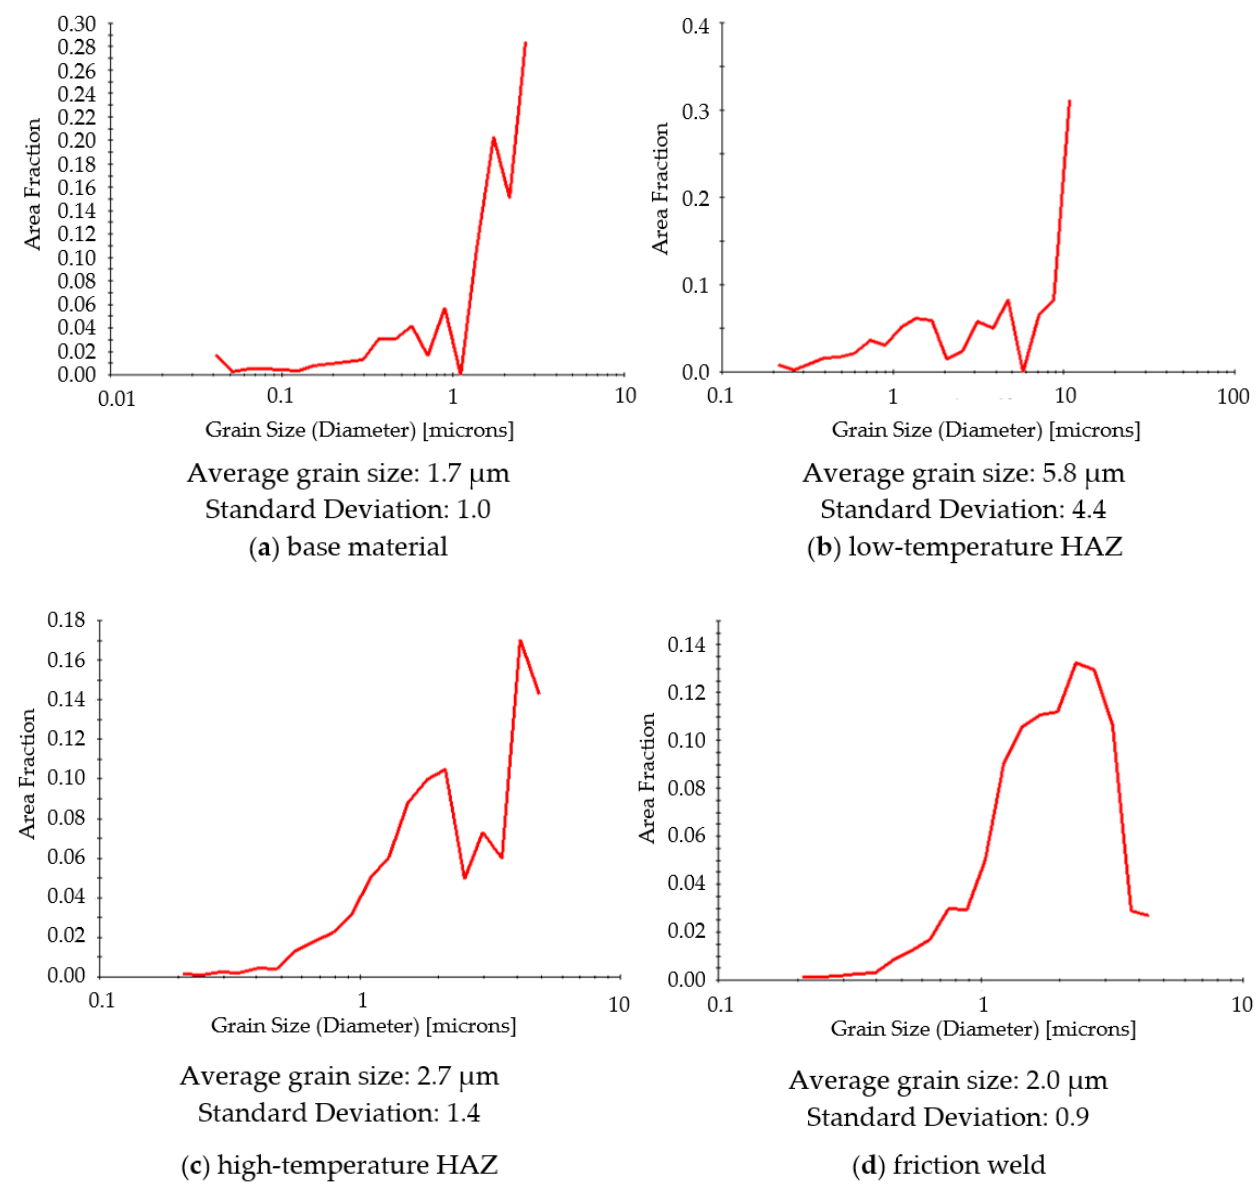
Figure 9. Grain size distribution in characteristic zones of friction-welded joints.